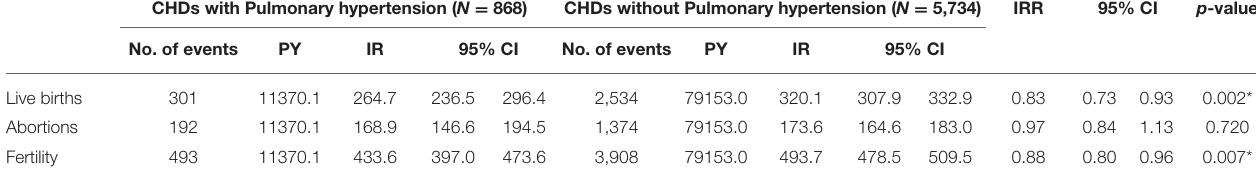
TABLE 5 | The influence of pulmonary hypertension on live births, abortions, and fertility among different CHDs. CHDs with Pulmonary hypertension ( N = 868) CHDs without Pulmonary hypertension ( N = 5,734) IRR 95% CI p